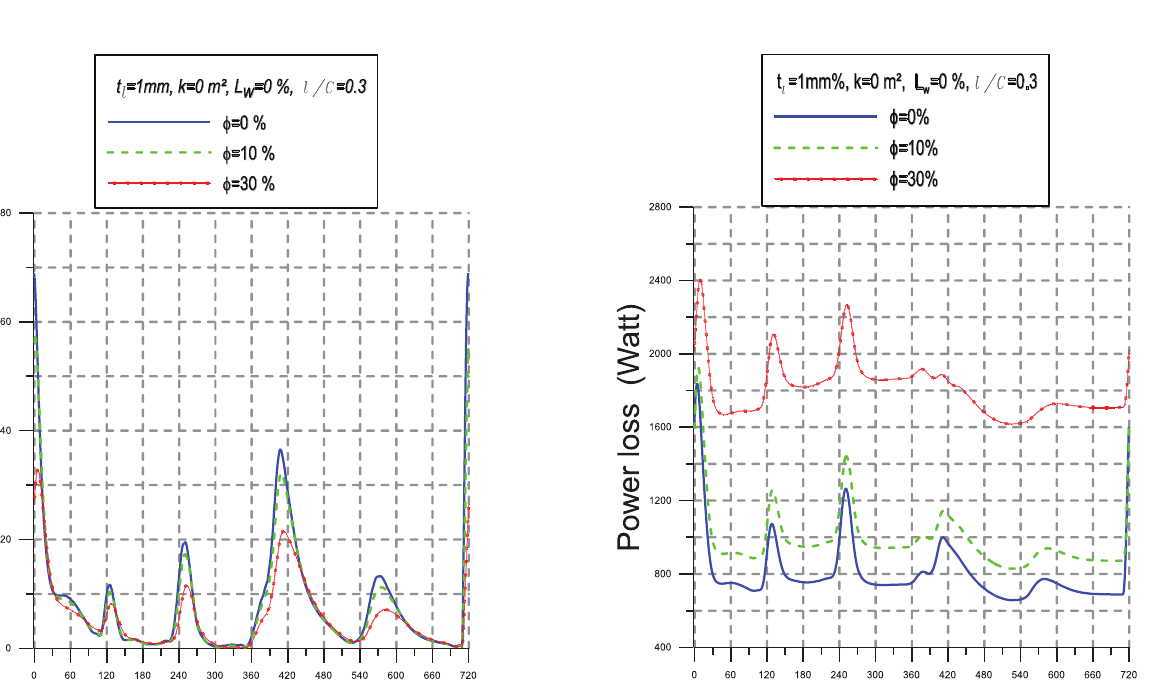
Fig. 20. Effects of the nanoparticles concentration parameter, f , on the minimum fi lm thickness over an engine cycle for the deformable case.